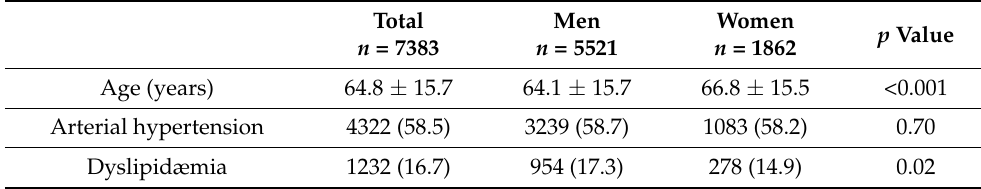
Table 1. Baseline Characteristics of patients who underwent endovascular thoracic aortic aneurysm repair (TEVAR). Results are expressed as mean +/ − SD or n